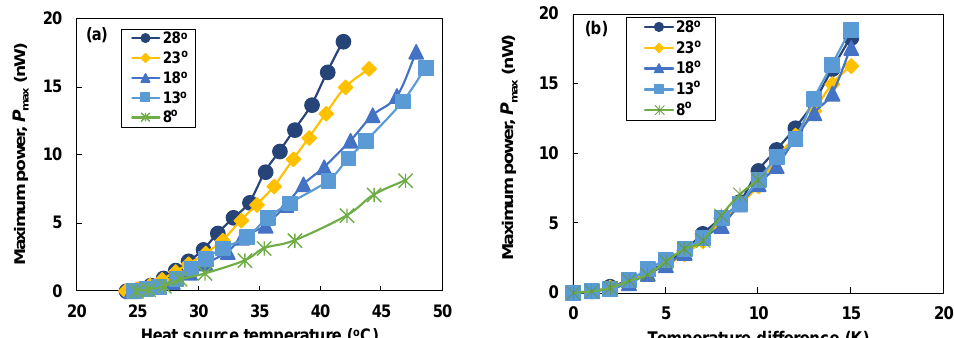
Figure 6. ( a ) Maximum power ( P max ) of thin-film thermoelectric generators as a function of temperature di ff erence ( ∆ T) and ( b ) P max of the generators as a function of ∆ T .